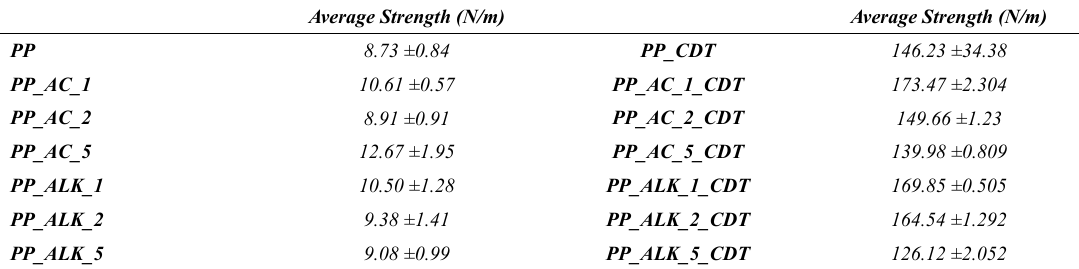
Table 4. Peel strength values for PP and PP KL